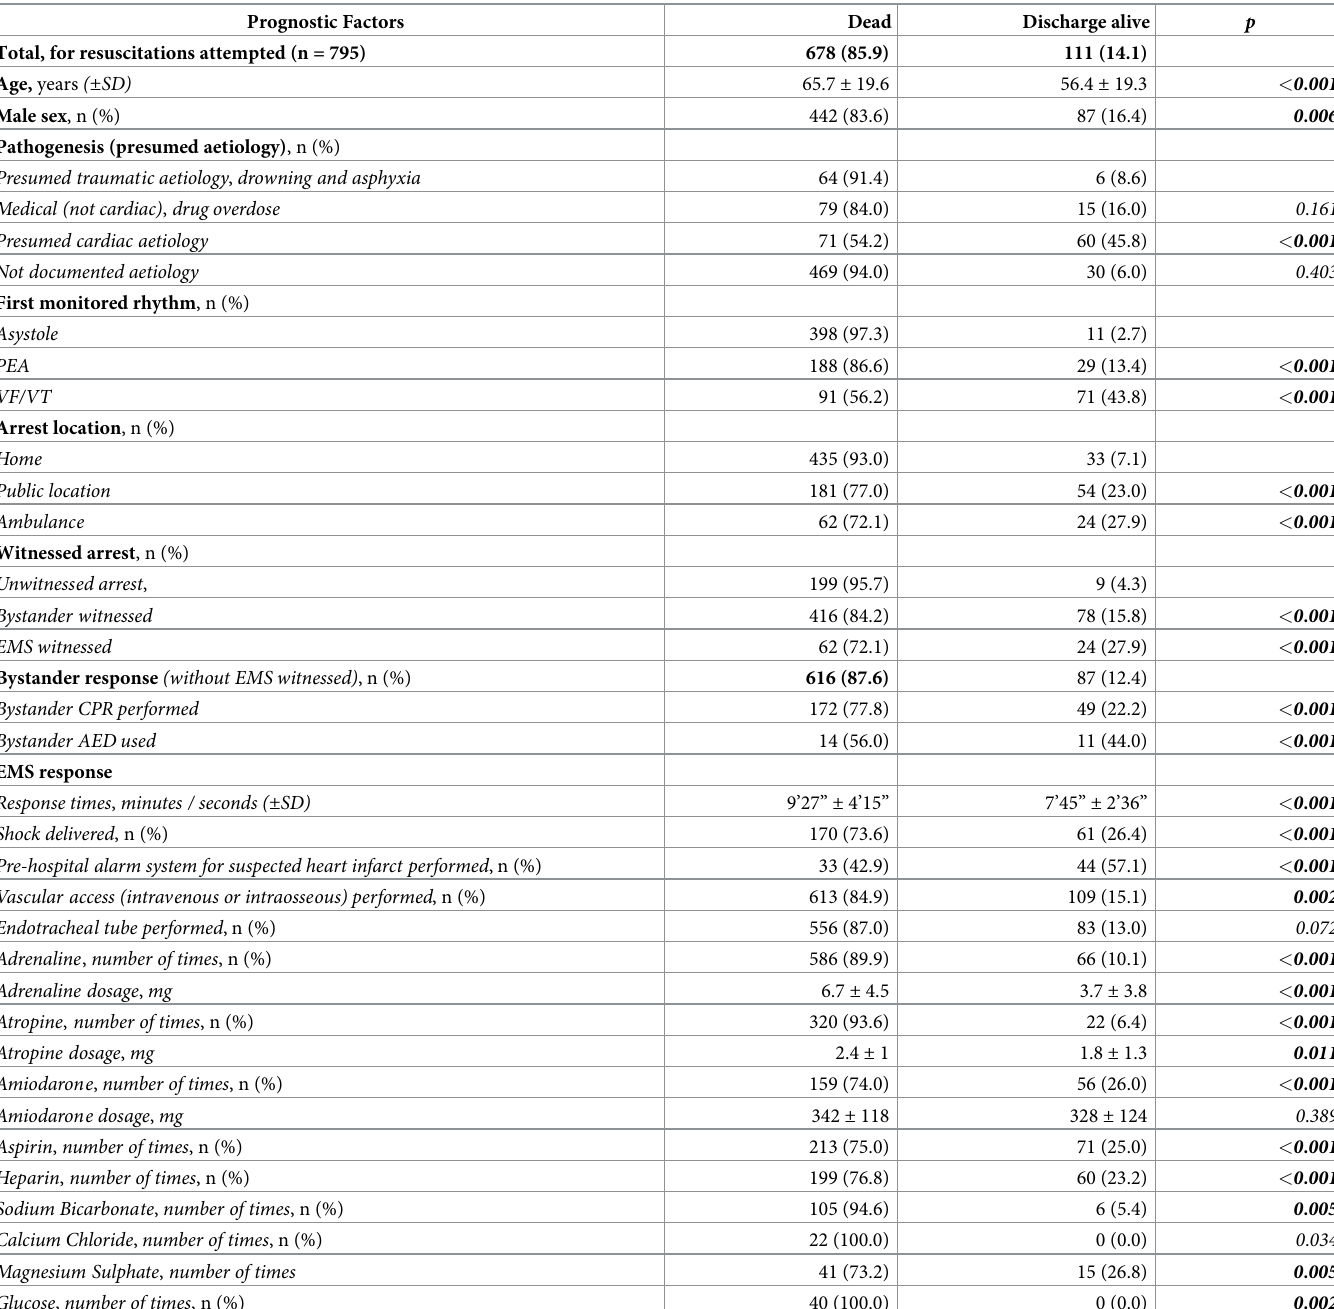
Table 2. Influence of the prognostic factors at the time of hospital discharge (univariate analysis for both periods as a whole). Prognostic Factors